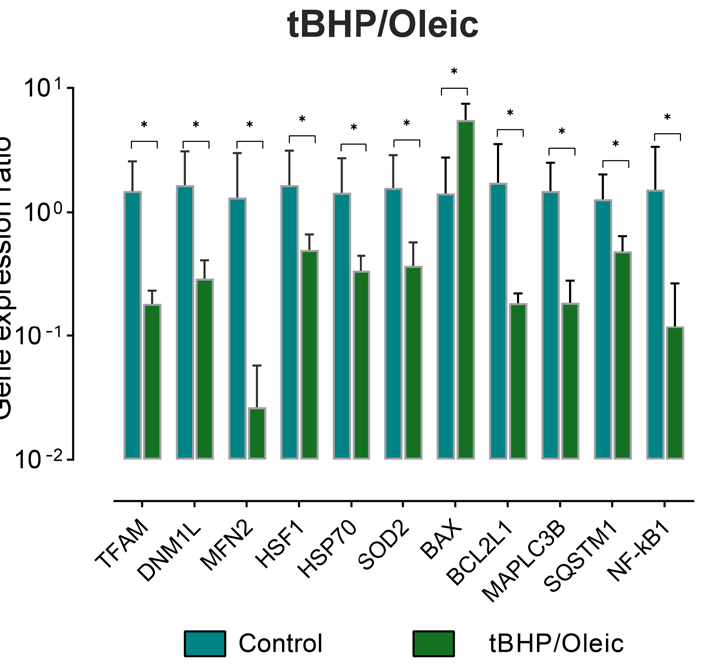
Figure 3. The level of gene expression in HepG2 cell model with the addition tBHP/Oleic. Mean ± SD; *— p < 0.05. The production of the most highly expressed marker proteins in the experimental model was analyzed: the production of mitochondrial dynamics proteins (Tfam, Dnm-1, Mfn-2), cytoprotectors associated with mitochondrial biogenesis (Hsp70, Sod-2), apopto- sis (Bax, NF-kB1) (Figure 4). When adding tBHP/Oleic protein products were not changed (Figure 4).